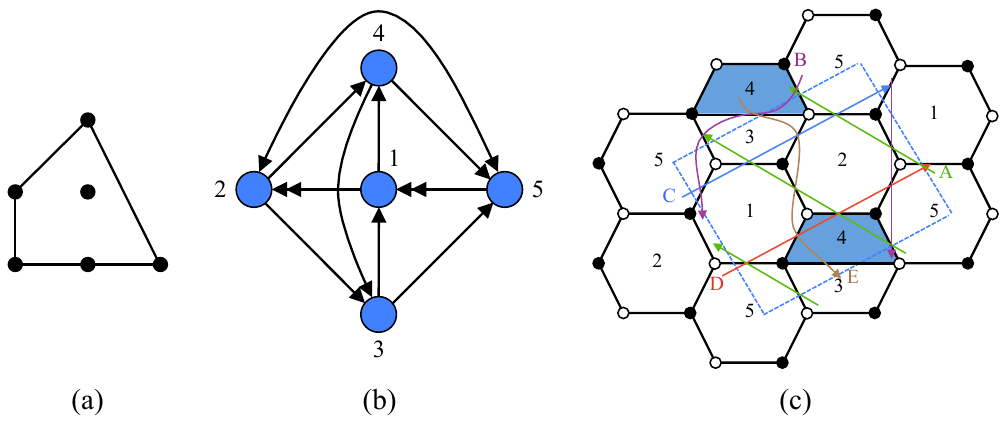
Figure 7. Diagrams for PdP 2 : a) toric diagram, b) quiver and c) dimer with zig-zag